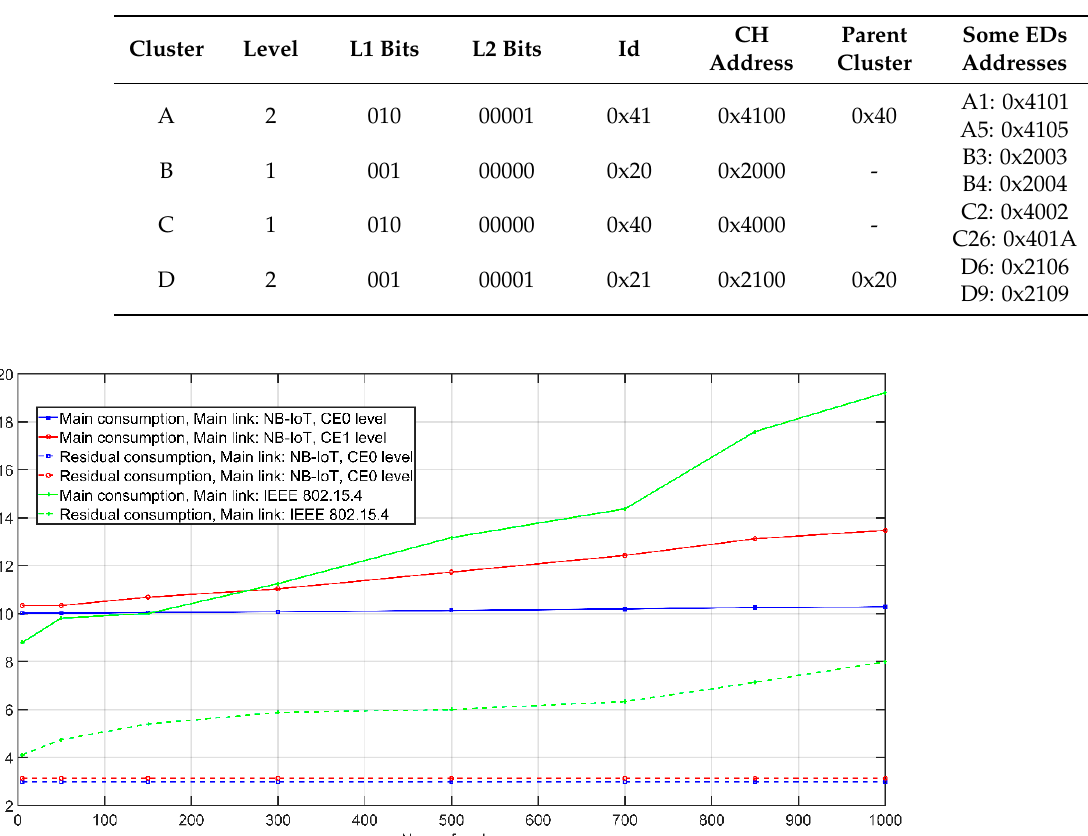
Table 5. Cluster identifiers and CH addresses from Figure 6 scheme.